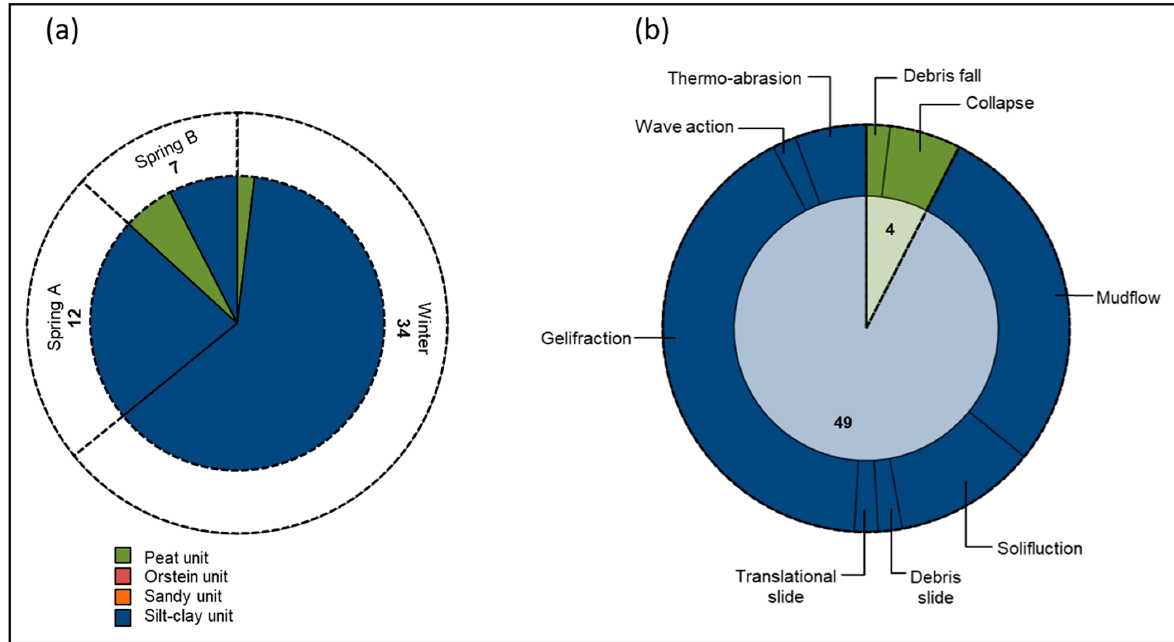
Figure 9. Number of events per lithological unit per season ( a ), and processes affecting the different lithologies in Zone C ( b ).